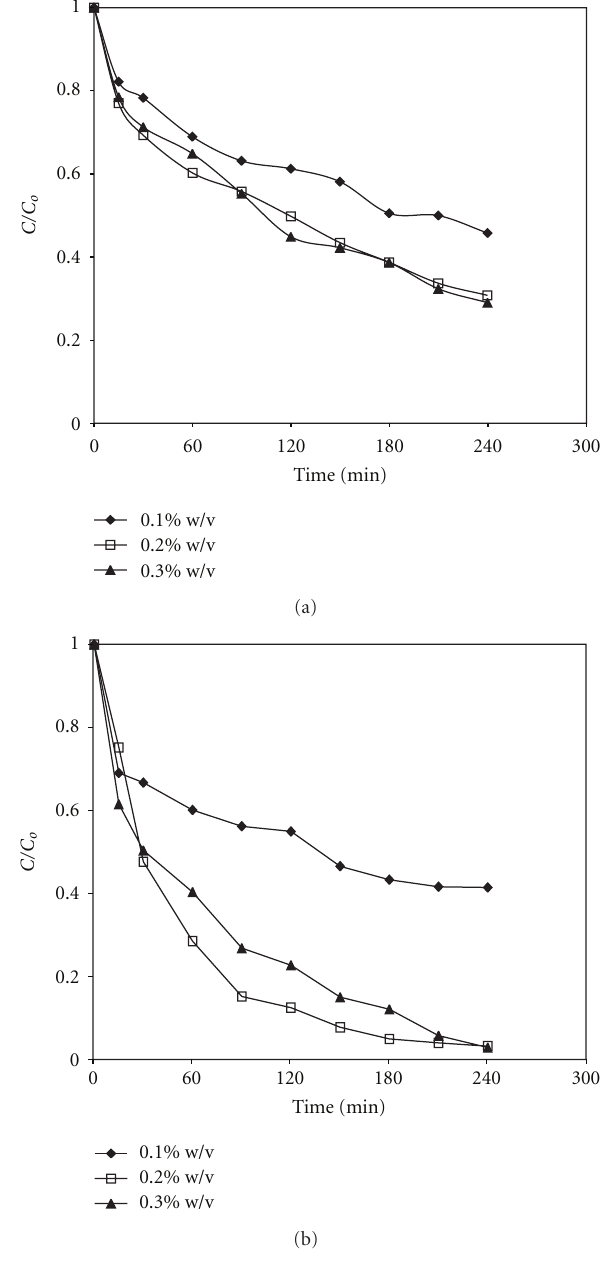
Figure 10: E ff ect of catalyst loading on photocatalytic degradation: (a) phenol, (b) o-